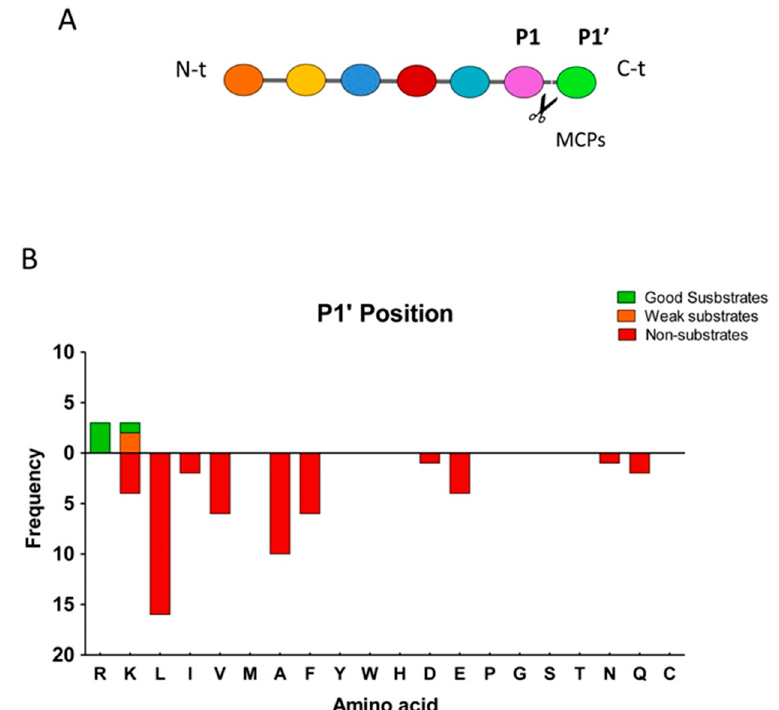
Figure 4. Analysis of the substrate preferences of CPZ from the peptidomics experiment using the HEK293T-derived peptide library. ( A ) Schematic representation of relevant residues involved in a typical MCPs cleavage, according to the model proposed by Schechter and Berger [32]; ( B ) Substrate preference of CPZ at the C-terminal (P1 ′ ) position. The frequency for each amino acid found in P1 ′ is indicated for good substrates, weak substrates, and non-substrates.